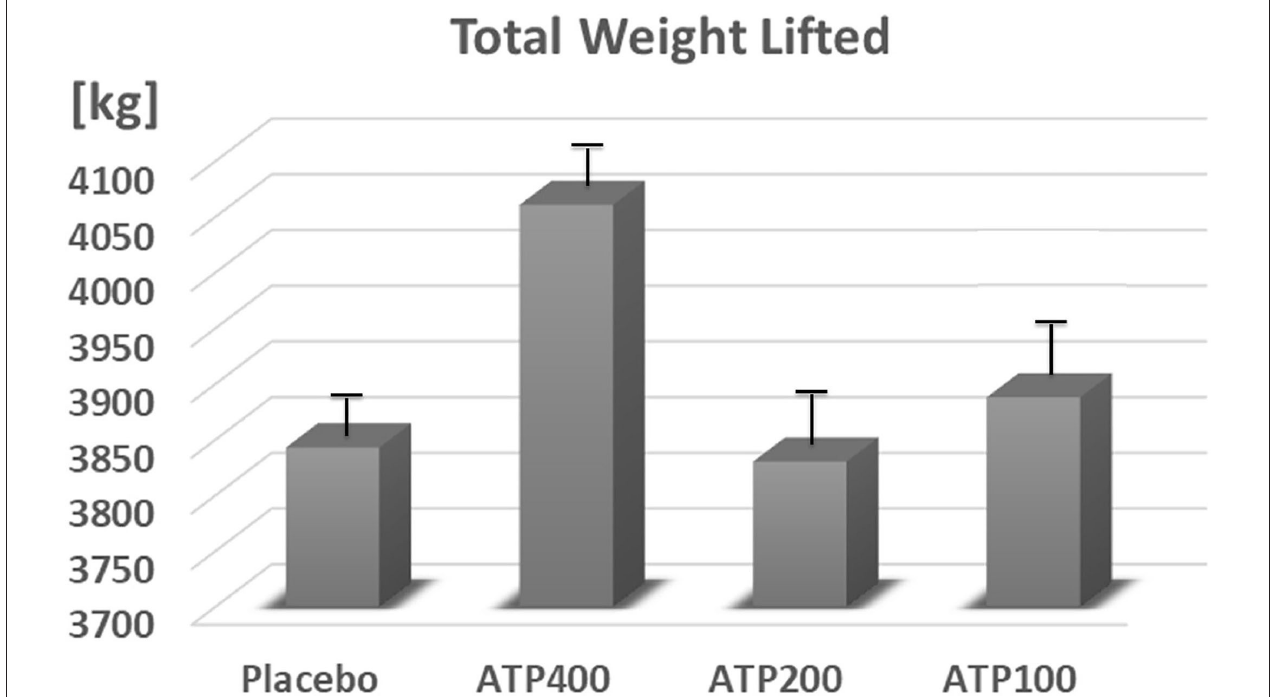
FIGURE 6 | 100mg ATP decreased the rate of perceived exertion (* p < 0.05 significantly different from placebo). Data are expressed as Least Squares-Means ± standard error.